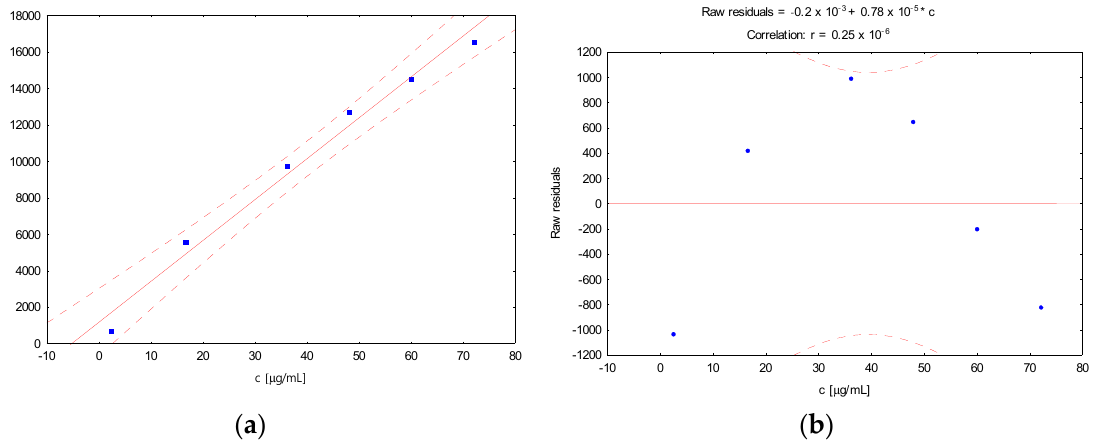
Figure 3. Plot of surface area [mm 2 ] vs. concentration of acetone solution of ceftobiprole [µg/mL] ( a ) and ( b ) graph of residues.